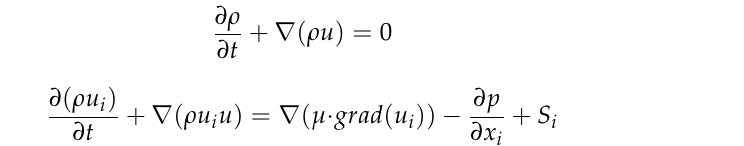
Figure 3. Bearing CFD analysis flow chart.